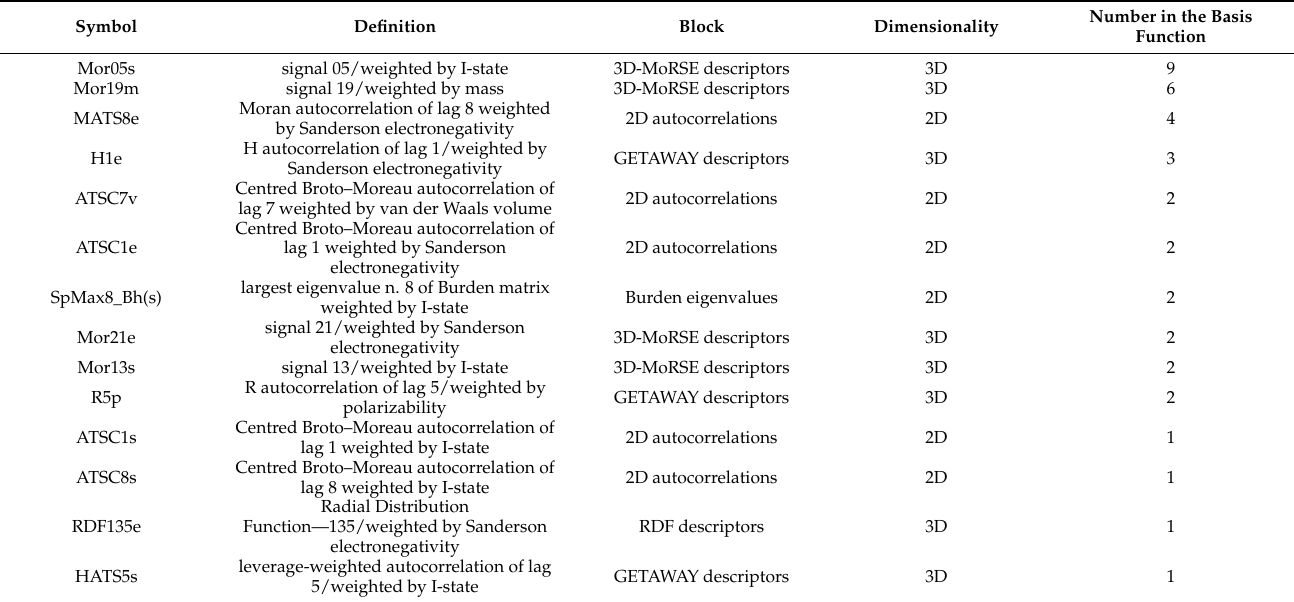
Table 2. Selected descriptors and the number of times they appeared in the basis functions of the MARS